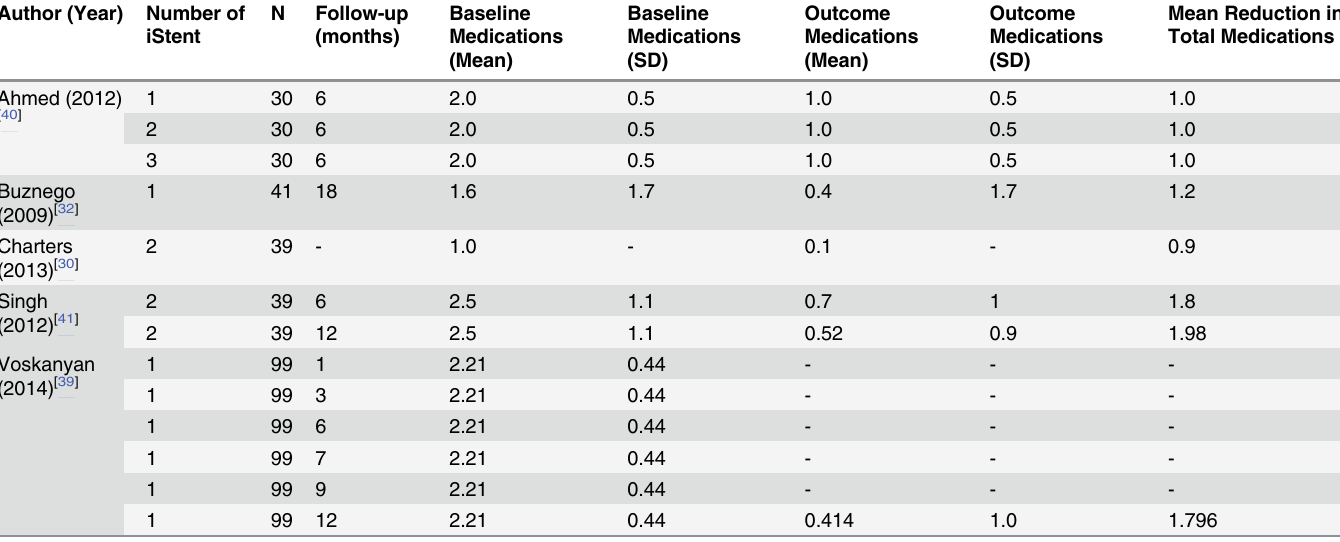
Table 2. Reported pre- and post-operative topical glaucoma medications in studies included in meta-analysis. Author (Year) Number of iStent